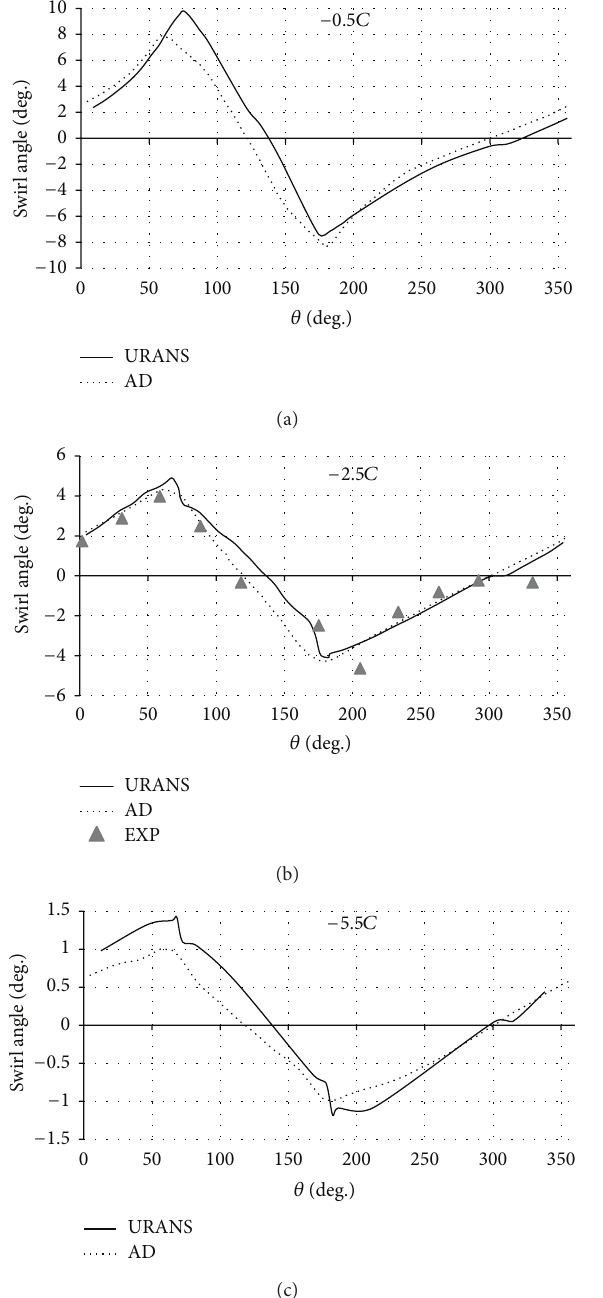
Figure 11: Comparison of the swirl angle for 3 reference planes.